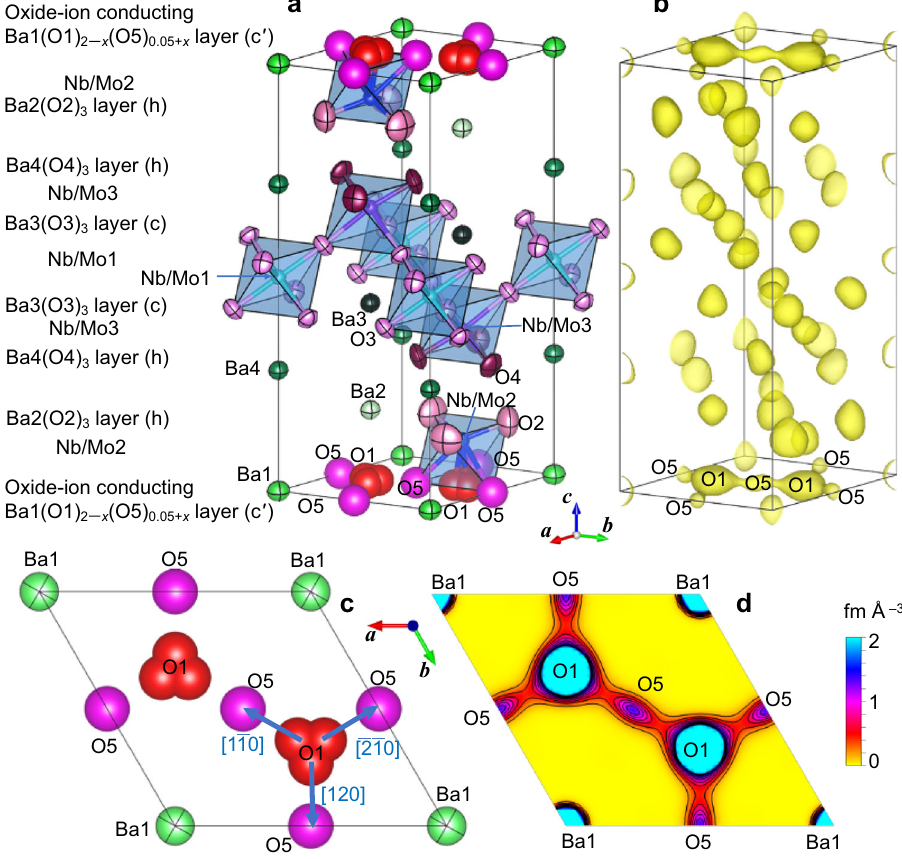
Fig. 2 Experimental evidence of the interstitial oxygen O5 and the O1 − O5 oxide-ion interstitialcy diffusion of Ba 7 Nb 3.9 Mo 1.1 O 20.05 at a high temperature of 800 °C. a Re fi ned crystal structure and b corresponding yellow isosurface of maximum-entropy method neutron scattering length densities (MEM NSLDs) at 0.36 fm Å − 3 of Ba 7 Nb 3.9 Mo 1.1 O 20.05 at 800 °C. Re fi ned crystal structure ( c ) and corresponding MEM NSLD distribution ( d ) on the ab plane at z = 0 of Ba 7 Nb 3.9 Mo 1.1 O 20.05 at 800°C. In d , the contour lines from 0 to 2 fm Å − 3 by the step of 0.2 fm Å − 3 . Thermal ellipsoids in panels ( a ) and ( c ) are drawn at the 90% probability level. Arrows in c denote the directions of oxide-ion O1-to-O5